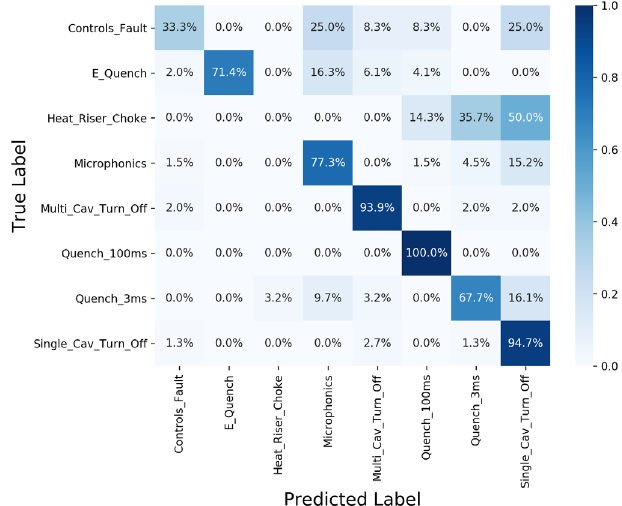
10. Confusion matrix showing performance of the de- ployed fault classification model on 312 fault events compared to the labels provided by a subject matter